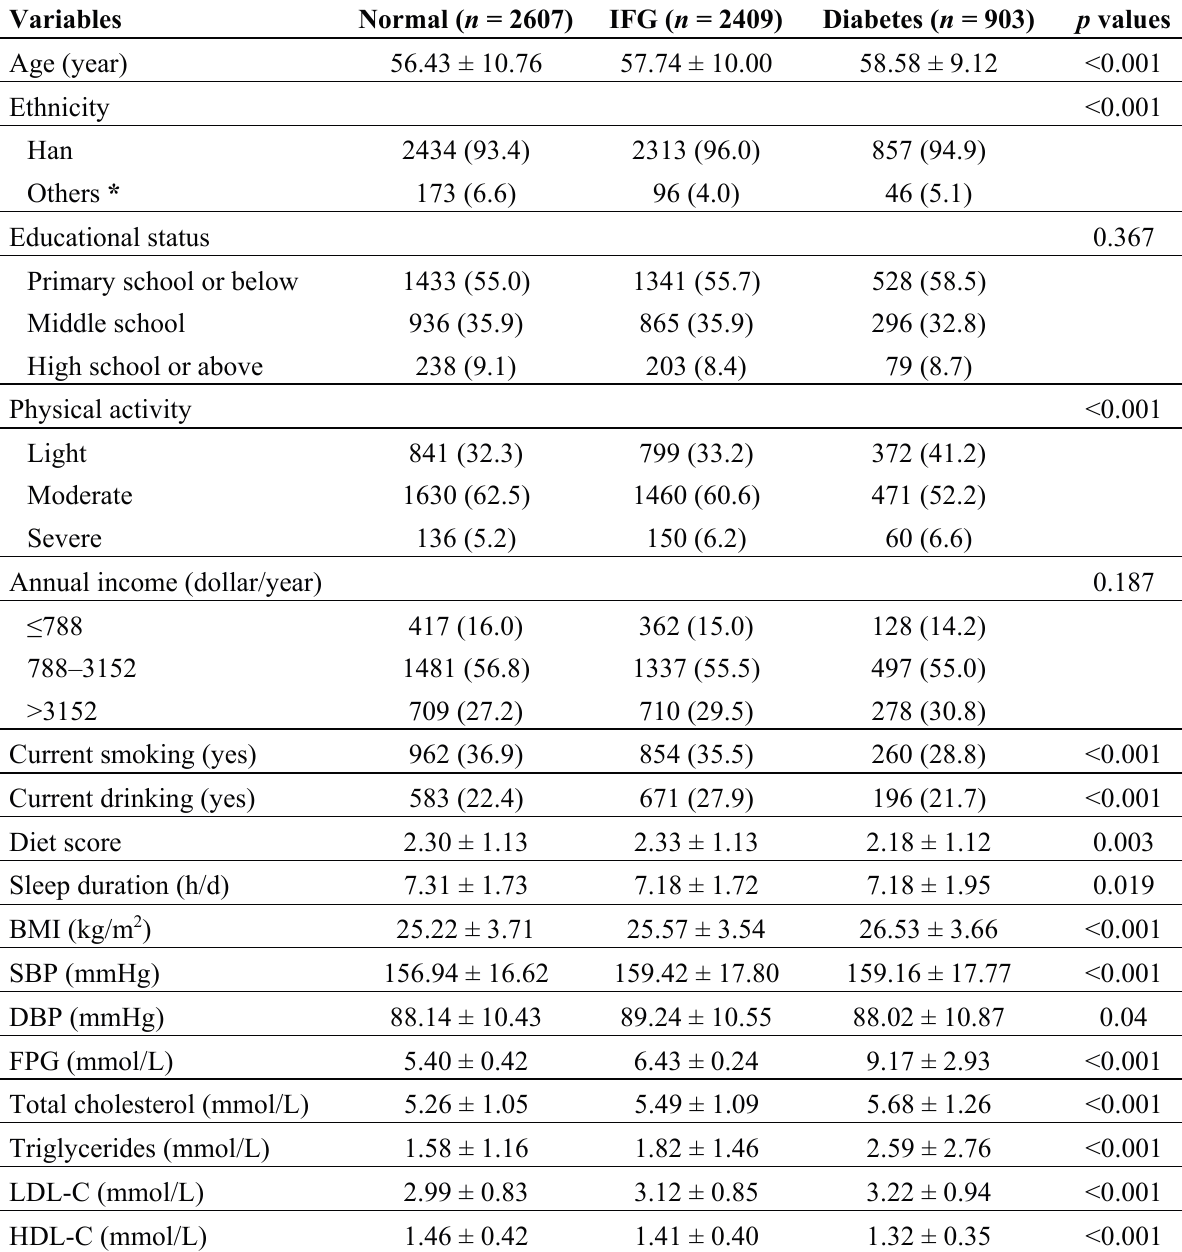
Table 2. Characteristics of study population with or without diabetes and IFG in the rural hypertensive population of Liaoning Province,